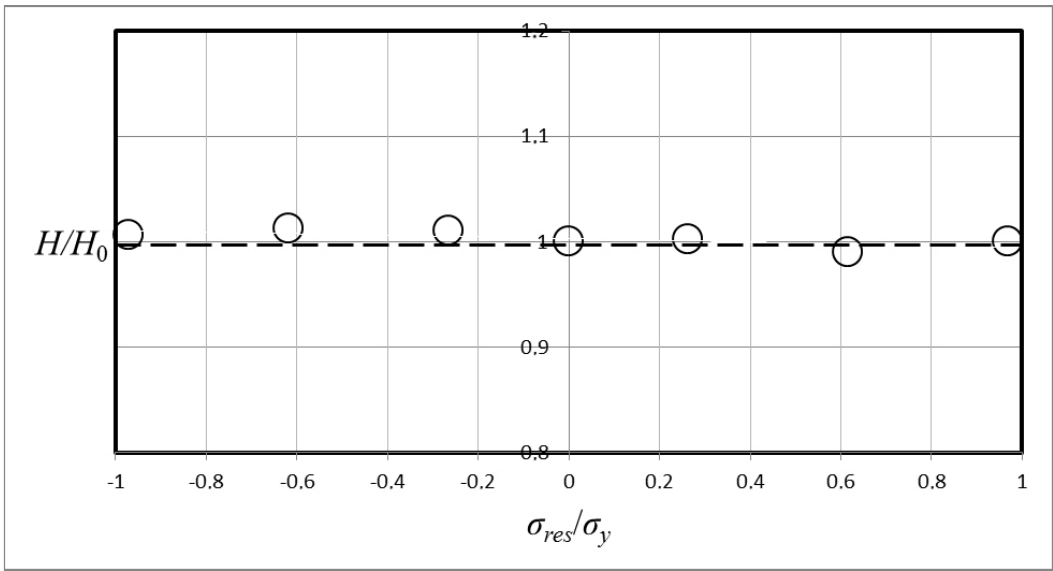
Figure 5. Nondimensionalized hardness, H / H 0 , as a function of the nondimensionalized equi-biaxial residual stress field, σ re s / σ y , at Vickers indentation. The results are pertinent to σ y = 200 MPa. (- - -), H / H 0 = 1. (o), numerical results for different values on σ re s / σ y .